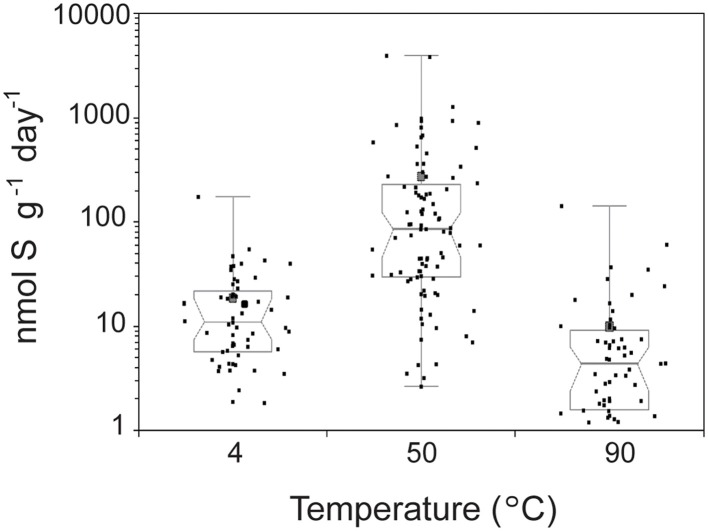
Temperature dependence of sulfate reduction rates in crushed hydrothermal flange from Grotto vent (Main Endeavor, JdF). The median of 213 samples is plotted as a line, the 1st and 3rd quartiles as a box, and the minimum and maximum as whiskers with end caps. The 95% confidence interval of the median is represented by a notch on the box. The mean of the 213 samples is depicted as a gray square. Black squares indicate individual measurements. Note rates measured from sulfate gradient experiments were excluded in this figure because those experiments were only done at 50°C.